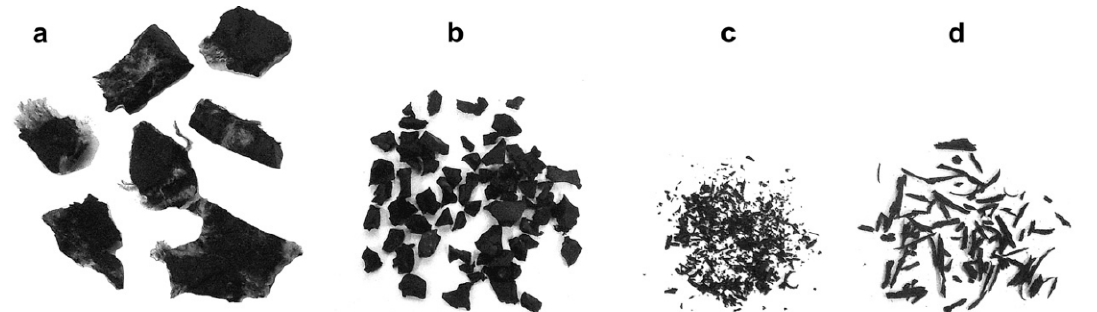
Figure 3. Categorization of waste rubber aggregates: ( a ) chipped, ( b ) crumb, ( c ) granular and ( d ) fibre [17]. Reproduced with permission from K. B. Najim and M. R. Hall, A review of the fresh/hardened properties and applications for plain- (PRC) and self-compacting rubberised concrete (SCRC); published by Elsevier, Construction and Building Materials, 2010.